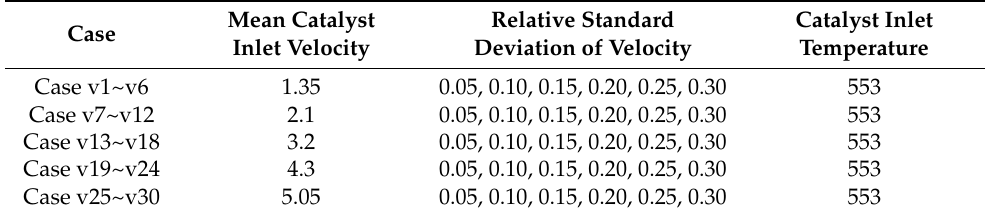
Table 4. Design of velocity random